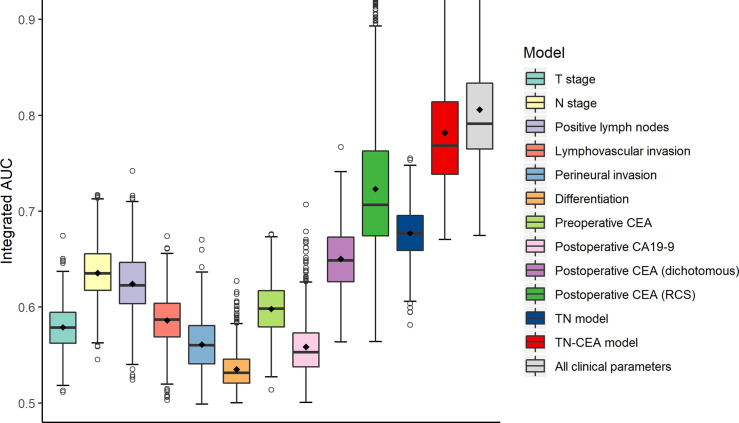
Clinical performance of tumor-related risk parameters. The predictive accuracy for disease-free survival based on the iAUC with 1,000 × bootstrap resampling for each parameter is shown as a box plot. The iAUC indicates integrated area under the ROC curve.